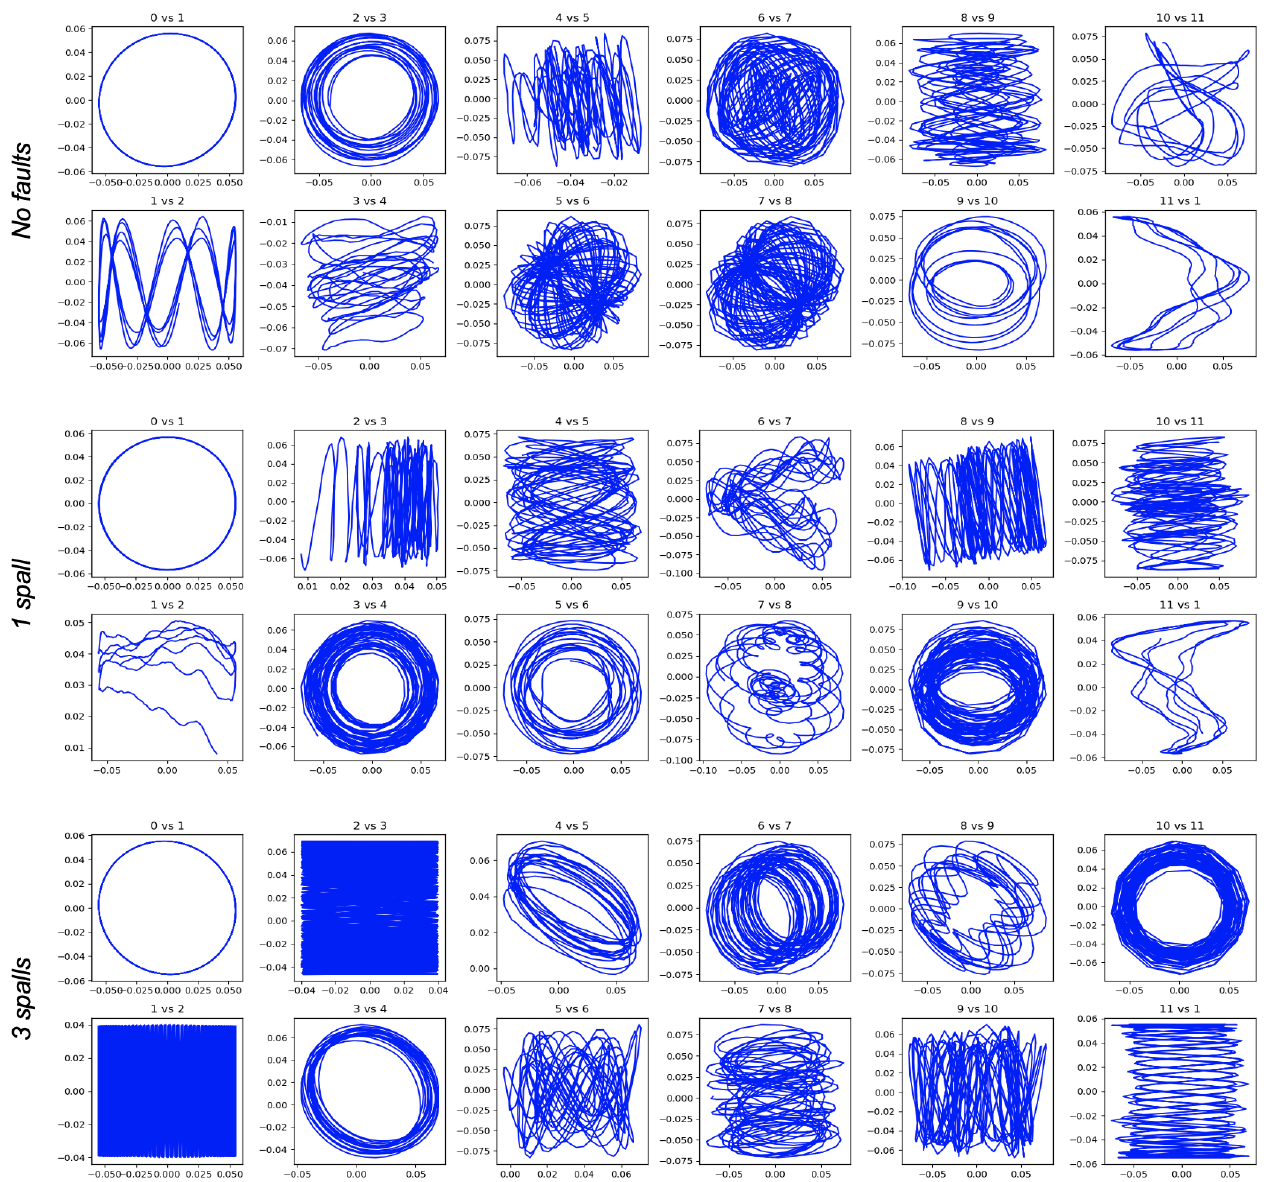
Figure 11. Scattergrams of eigenvectors for phase A of the bearing without faults, the bearing with one spall and the bearing with three spalls. one spall and the bearing with three